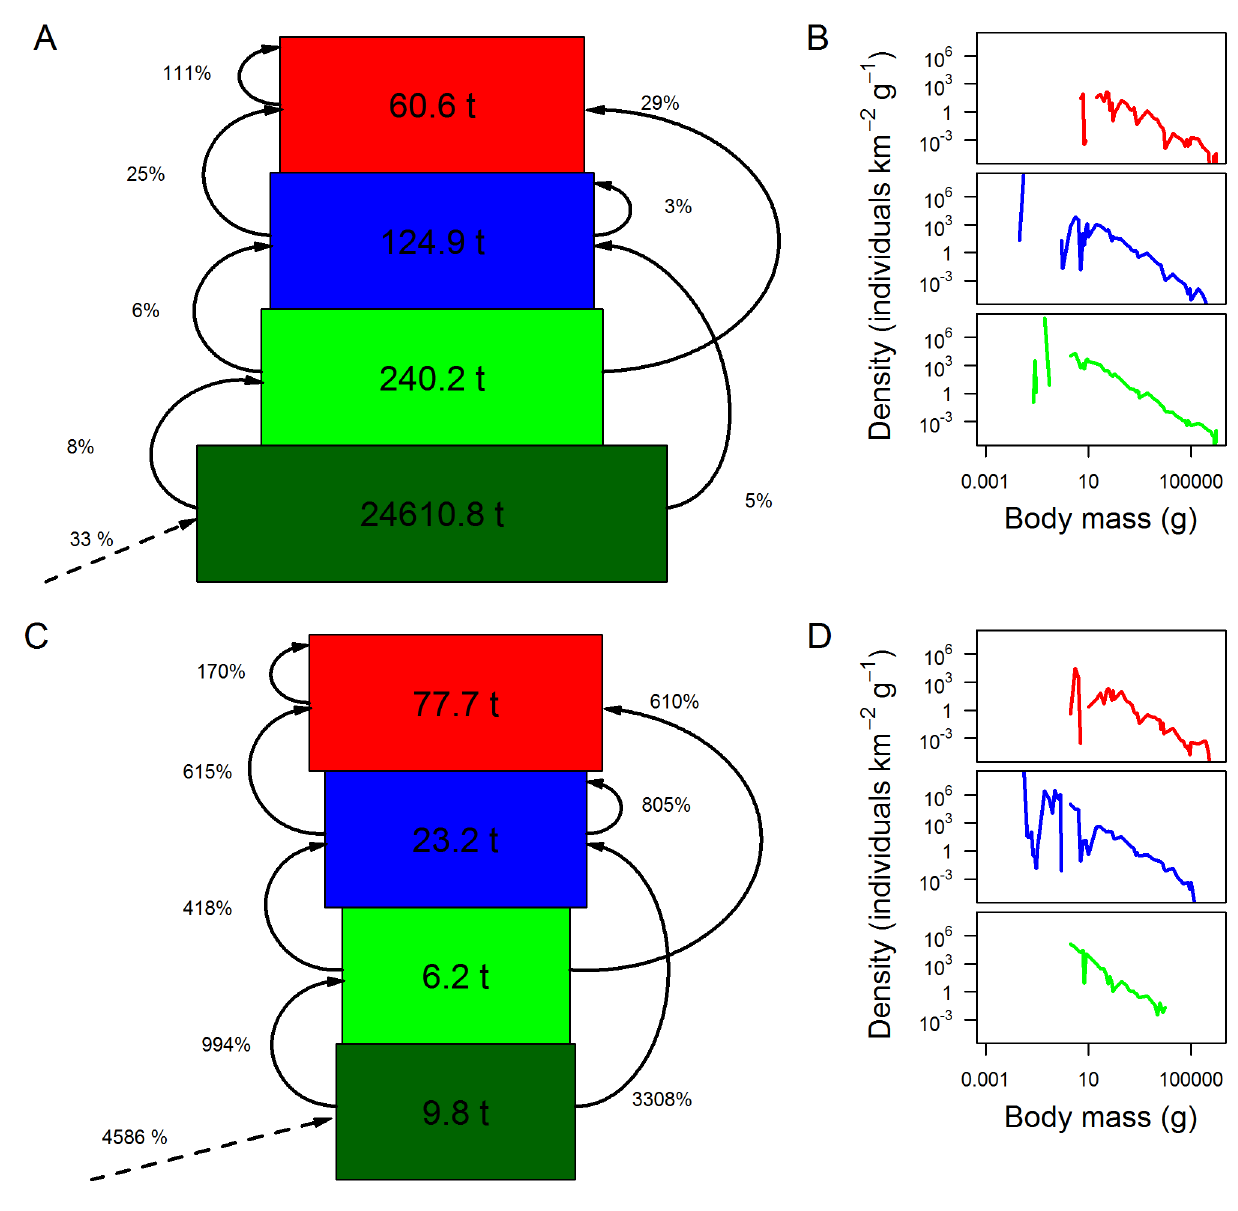
Figure 4. Community-level emergent properties. Community-level properties—(A, C) biomass pyramids and (B, D) body mass–density relationships across all cohorts belonging to each trophic level—emergent from the model for an example terrestrial (A, B) and marine (C, D) grid cell (grid cells T1 and M1 from Table 4). Results are from the final year of a 100-y model run. Dark green represents autotrophs, light green herbivores, blue omnivores, and red carnivores. In (A) and (C), standing stocks of biomass are indicated by the widths (after log-transformation) and numbers within the boxes; curved arrows and percent values represent the biomass transferred among or within trophic levels from herbivory and predation, as a proportion of the standing stock of the source of each flow; dashed arrows and percent values represent NPP of autotrophs as a proportion of the autotroph standing stock.